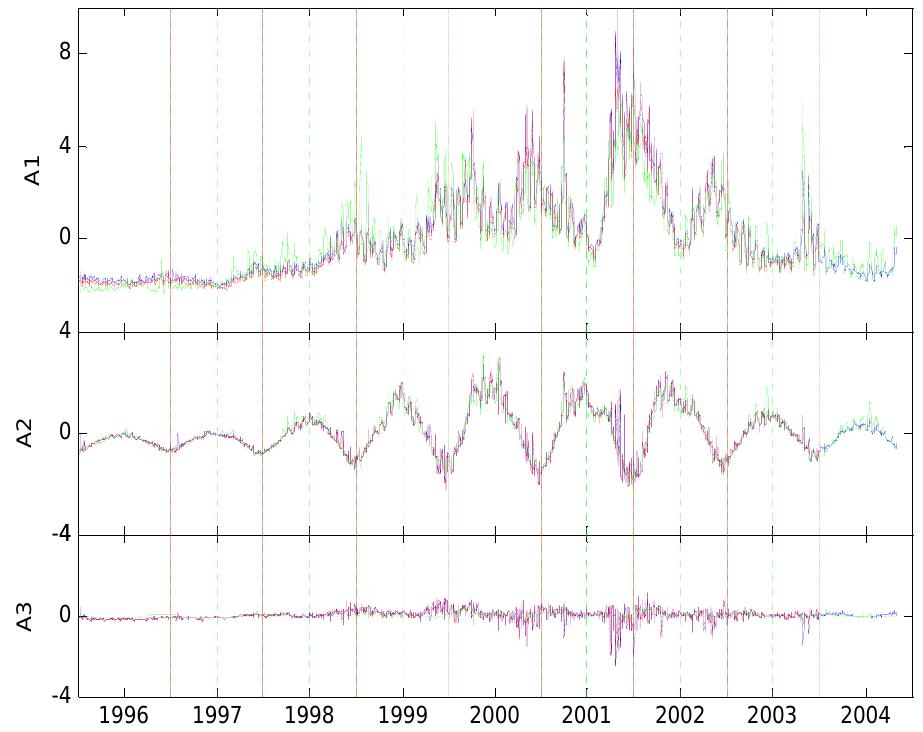
Fig. 10. The red line represents the first EOF coefficient A1 that is derived from the 1996–2003 data set. The blue line denotes A1 that is that derived from Figure 10. red line represents the first EOF coefficient A derived from the 1996–2004 data set. The green line indicates the modeled A1 using the A1 from 1 1996-2003 data set. Blue line denotes A that derived from 1996-2004 data set. Green 1 using the A from 1996-2003. line indicates the modeled A 1 1